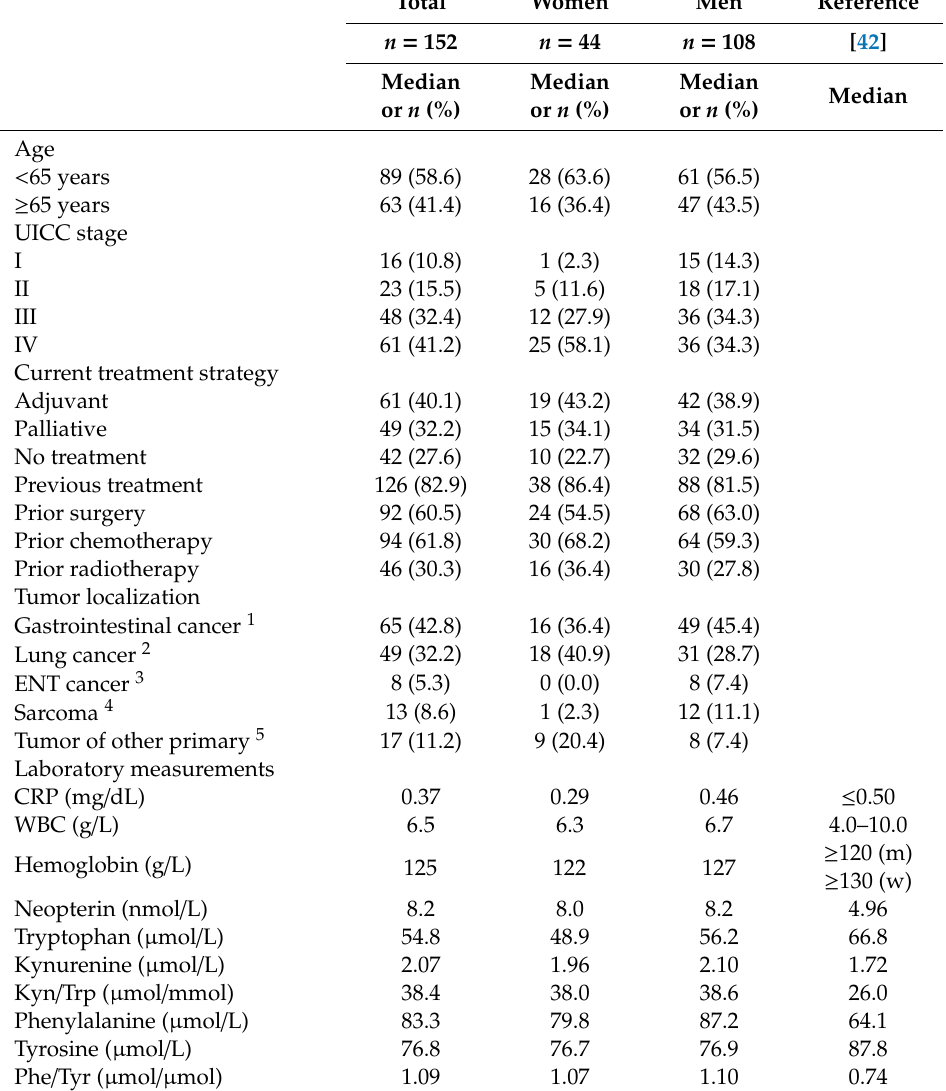
Table 1. Patient characteristics and median concentrations of the investigated lab parameters